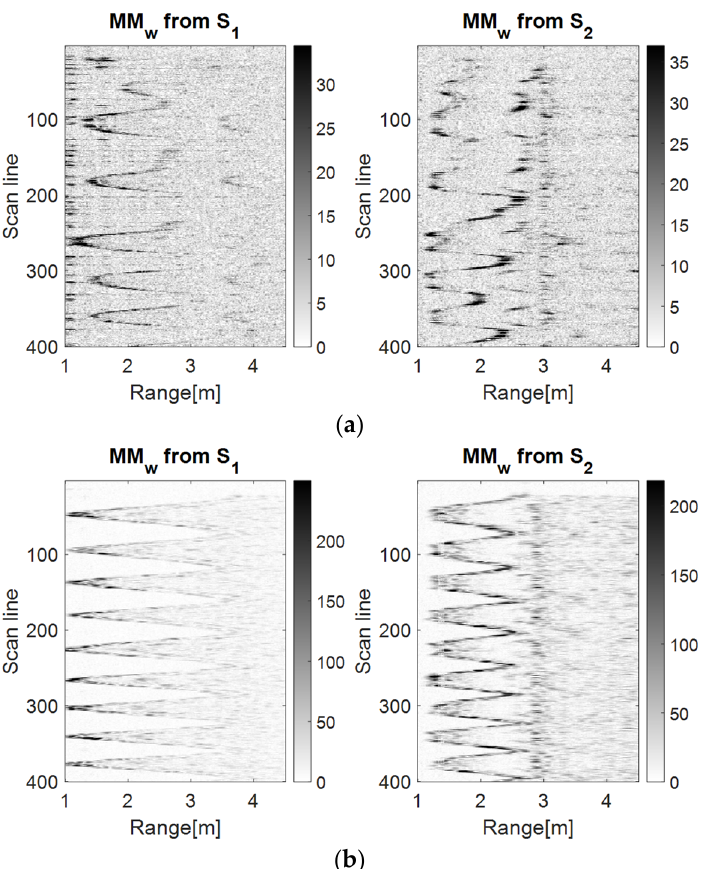
Figure 5. The drone ( a ) and the human ( b ) forward–back movement maps using the wavelet analysis using the Morlet wavelet as the mother function.